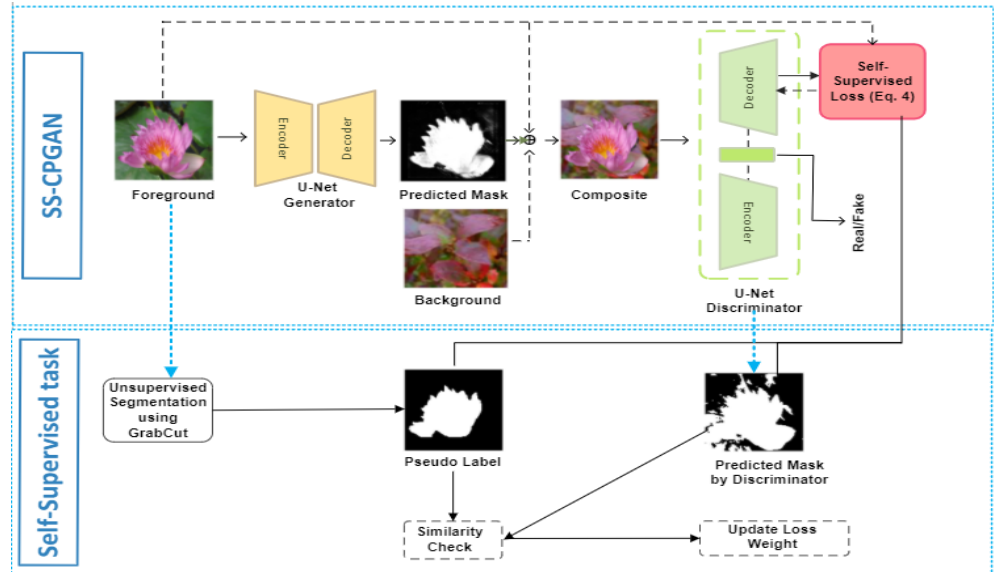
Figure 2. The proposed self-supervised cut-and-paste GAN